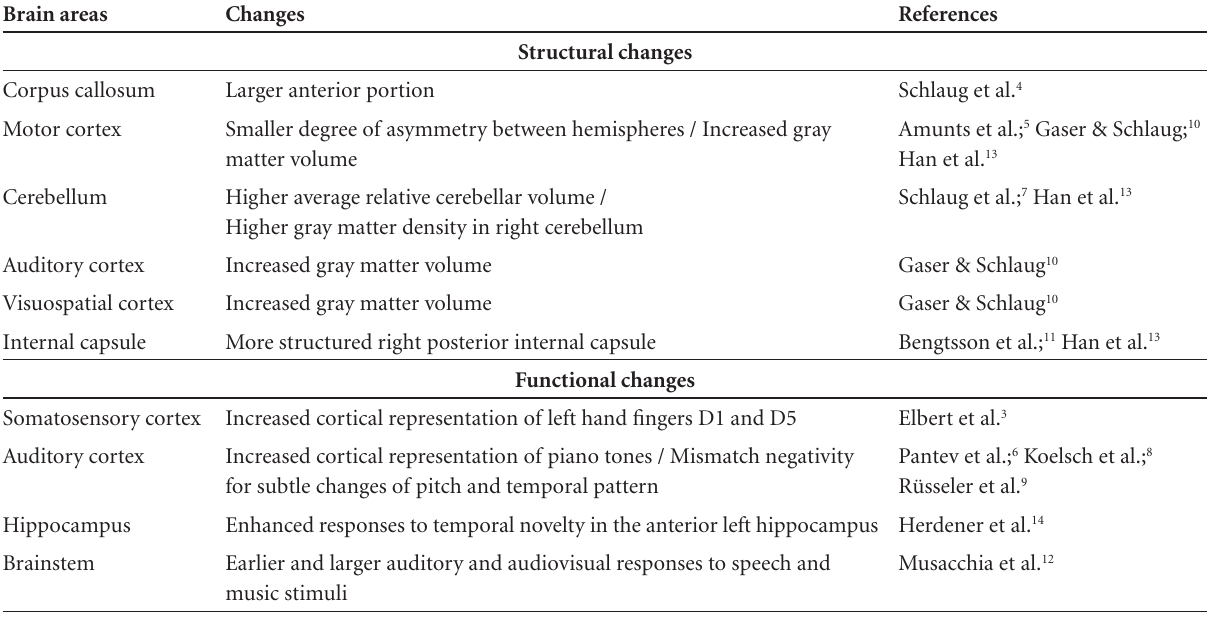
Table 1. Some structural and functional changes identified in musicians’